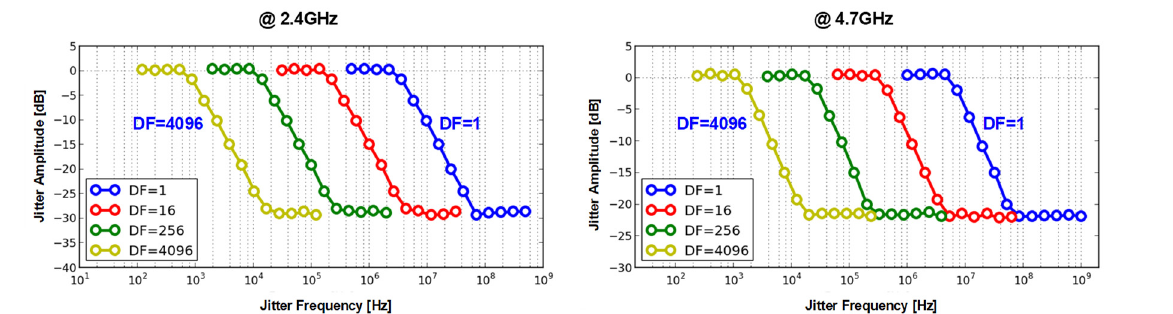
Figure 11. Simulated jitter transfer simulation results at 2.4 GHz and 4.7 GHz.